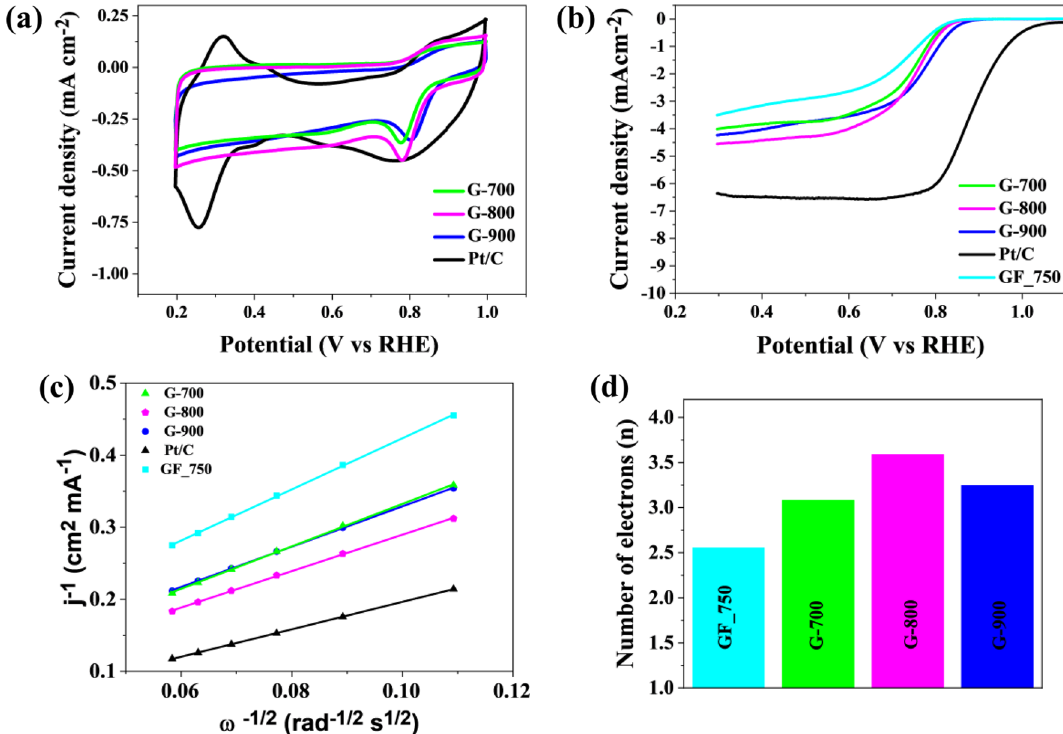
Figure 8. ( a ) CV curves of the obtained electrocatalysts and Pt/C catalysts in an O 2 -saturated 0.1 M KOH solution; ( b ) LSV curves of G-700, G-800, G-900 and Pt/C catalysts measured at a scan rate of 5 mV s −1 and a